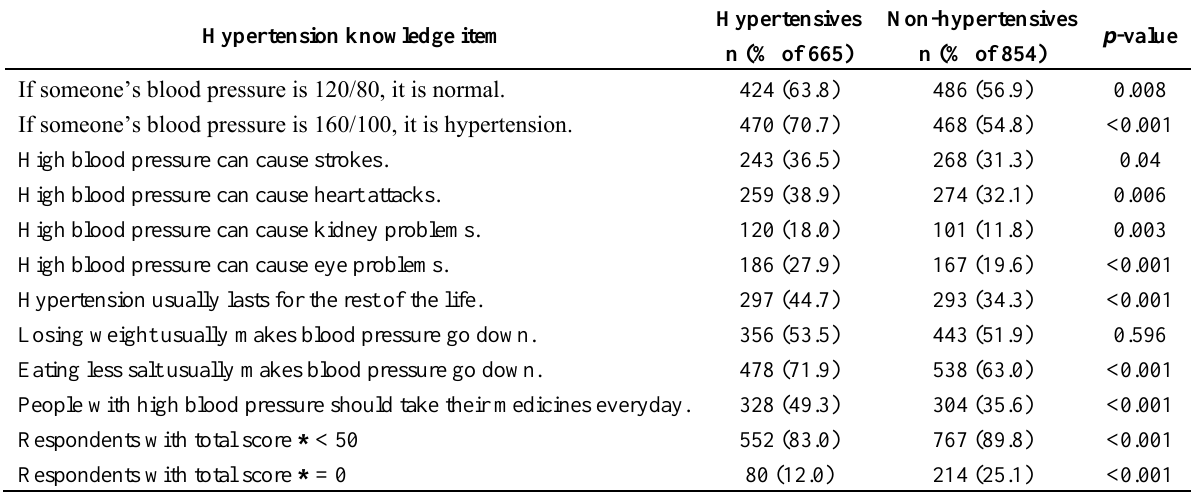
Table 2. Percentage of survey respondents with correct responses to hypertension knowledge